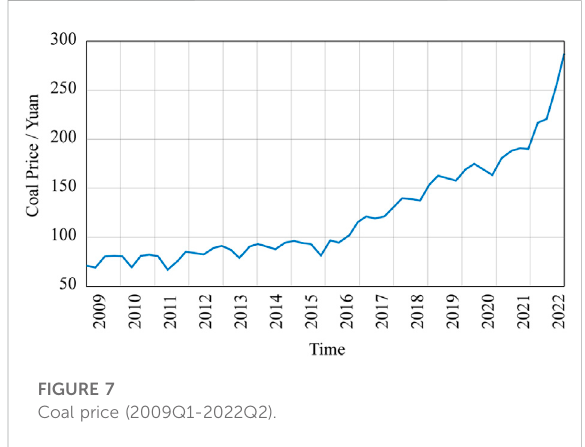
FIGURE 7 Coal price (2009Q1-2022Q2).